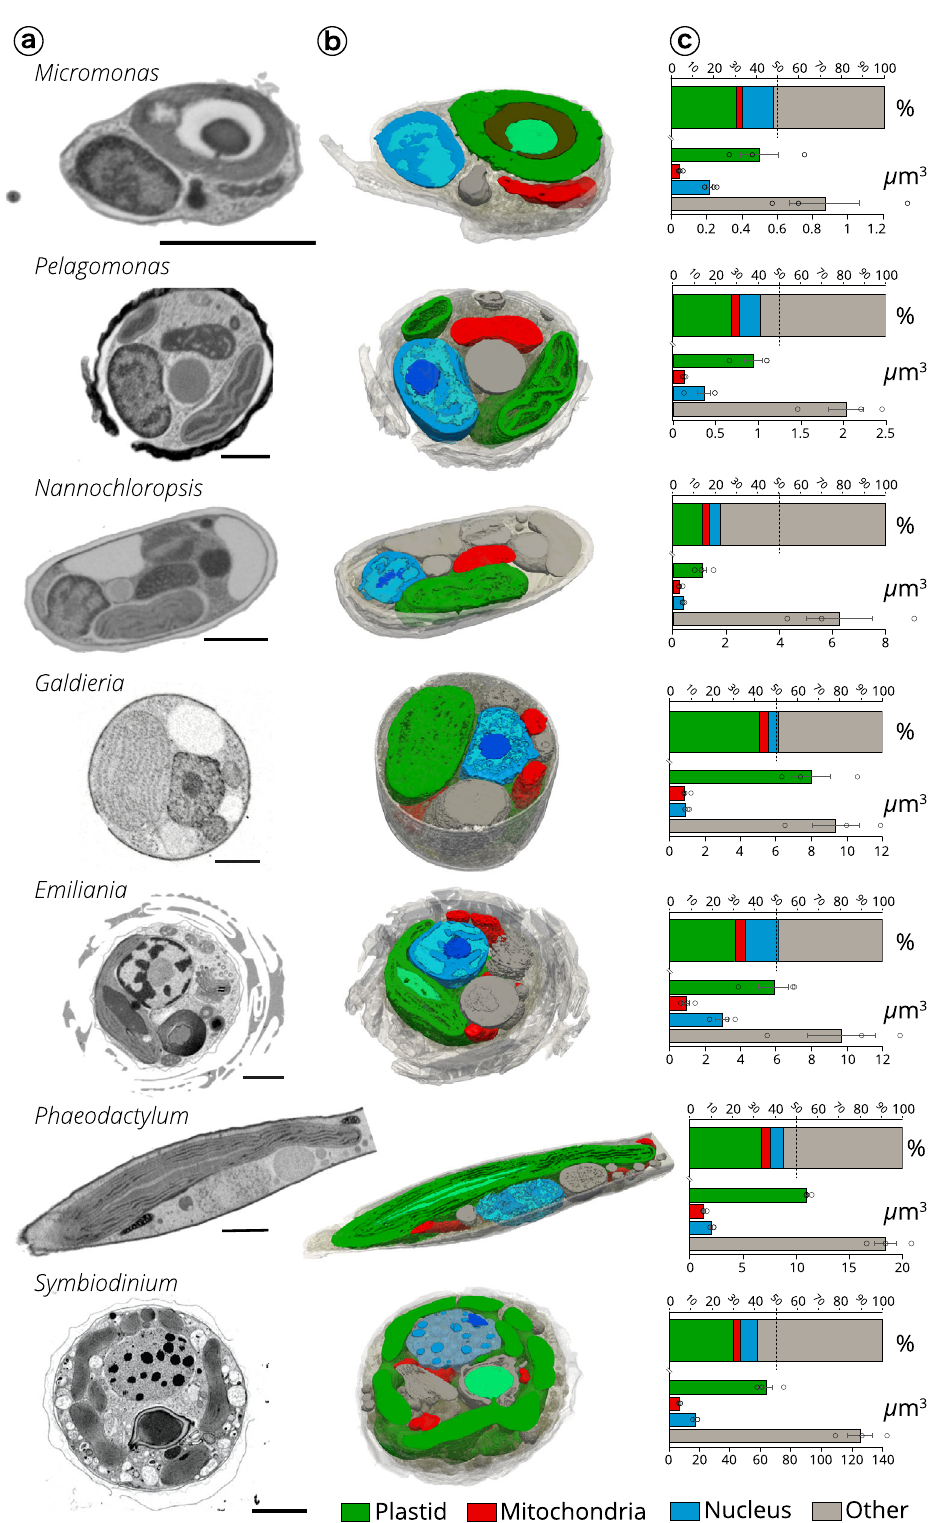
Fig. 2 Internal cell architecture of phytoplankton cells. a Sections through cellular 3D volumes, segmented from FIB-SEM images of whole cells of Micromonas (stack of frames in Supplementary Movie 1), Pelagomonas (Supplementary Movie 2), Nannochloropsis (Supplementary Movie 3), Galdieria (Supplementary Movie 4), Emiliania (Supplementary Movie 5), Phaeodactylum (Supplementary Movie 6) and Symbiodinium (Supplementary Movie 7). Sections are representatives micrographs of an experiment repeated three times with similar results Scale bar: 1 µ m. b Segmentations highlight the main subcellular compartments: green: plastids (containing thylakoids and pyrenoids — light green — in some cell types); red: mitochondria; blue: nuclei (with different intensities of staining possibly corresponding to euchromatin — light blue — heterochromatin — blue and the nucleolus — dark blue); grey: other compartments. Segmentations are representatives tomograms of an experiment repeated three times with similar results. c Volume occupancy by the different subcellular compartments in different microalgal cells. Top plot: % of cell-volume occupation; bottom plot: absolute volume sizes. Data refer to three cells ± s.d. for every